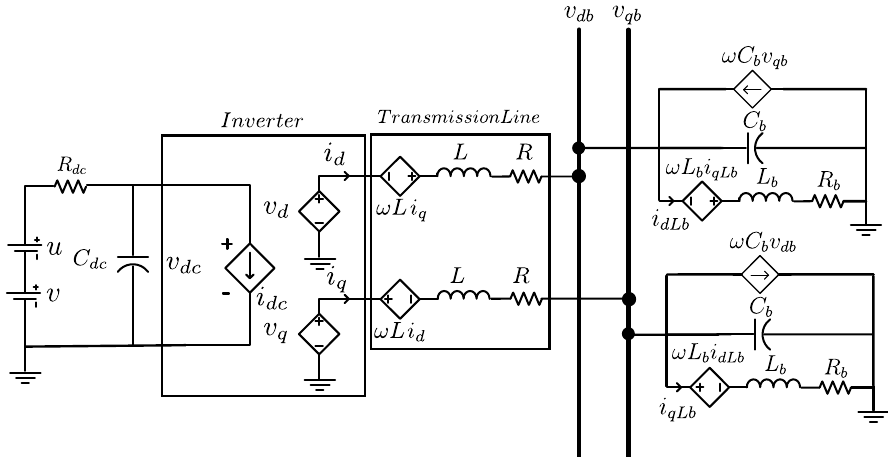
Figure 1. Simplified Microgrid model in d-q coordinates including a Distributed Generation Unit (DGU) and an RLC